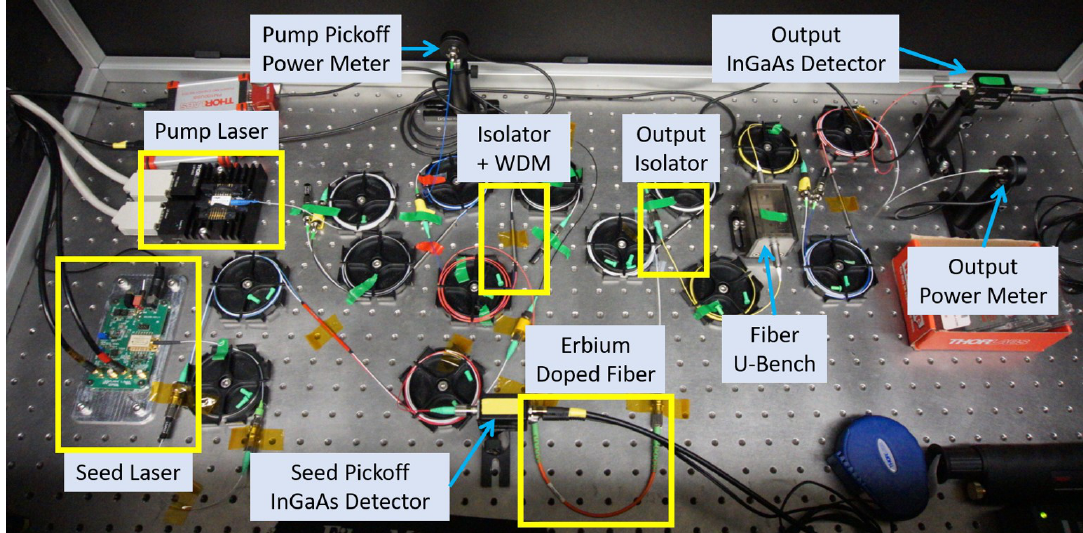
Figure 7. The FLAT benchtop optical amplifier setup at the University of Florida in a forward pumping configuration. The FLAT was used to characterize the transmitter hardware for MOCT.